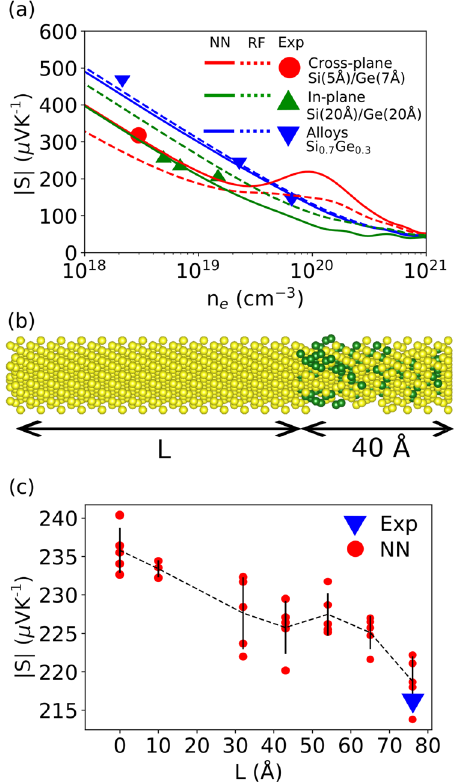
Fig. 6 Prediction of thermopowers of fabricated structures using ML models. Each model is trained with DFT data obtained from 16- atom fragment units: a Predicted thermopower (NN (solid lines), RF (dashed lines)) of n -type SLs and alloys compared to measured data 17,53,54 . b Representative model Si/Si 0.7 Ge 0.3 SL. Length ( L ) of Si region is varied while keeping length of Si 0.7 Ge 0.3 region fi xed. c S of p -type Si/Si 0.7 Ge 0.3 SLs at carrier concentration, n e = 1.5 × 10 19 cm − 3 predicted with NN algorithm and compared with measured data 55 . Predicted S ’ s converge to measured value from below with increasing L . Spread in NN predictions represent fi ve randomized Si 0.7 Ge 0.3 con fi gurations, considered for each L .